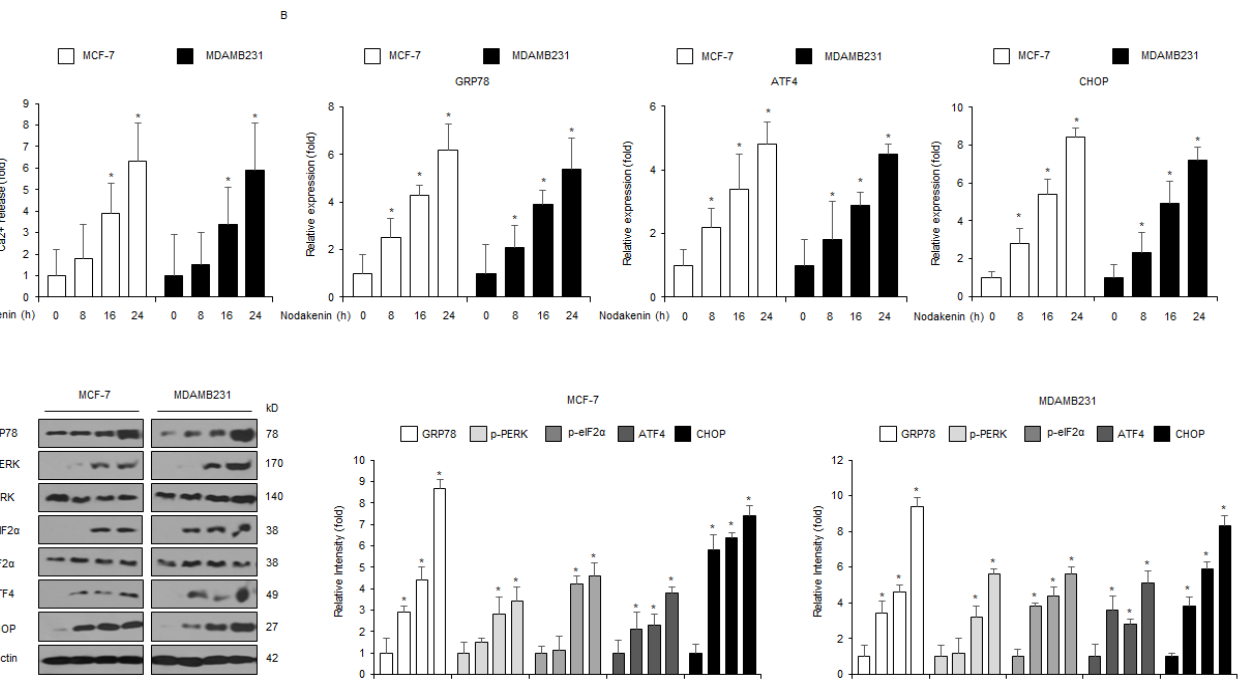
Figure 2. Nodakenin induces apoptosis and cell death in breast cancer cells. ( A – D ) After nodakenin